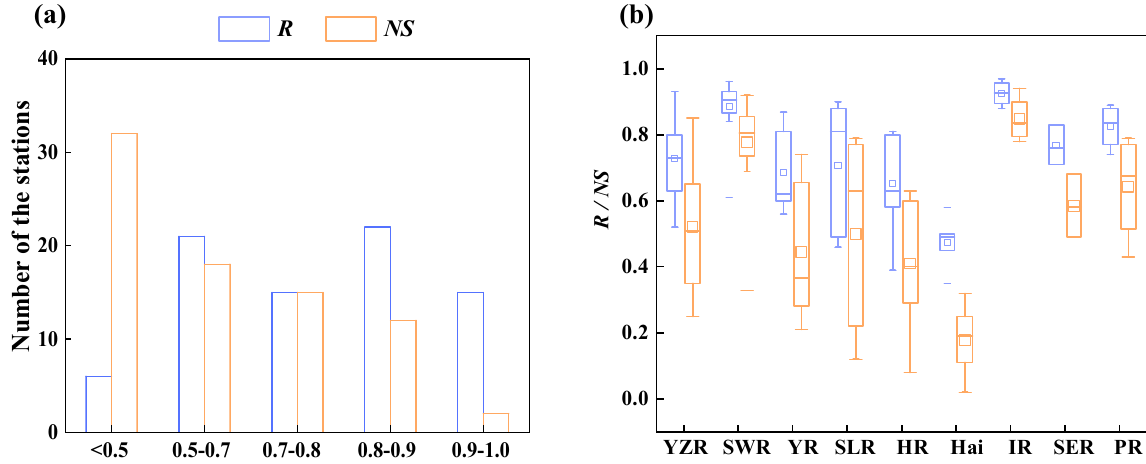
Figure 4. ( a ) Statistics of each category and ( b ) comparisons between basins for R and NS of the 79 stations.